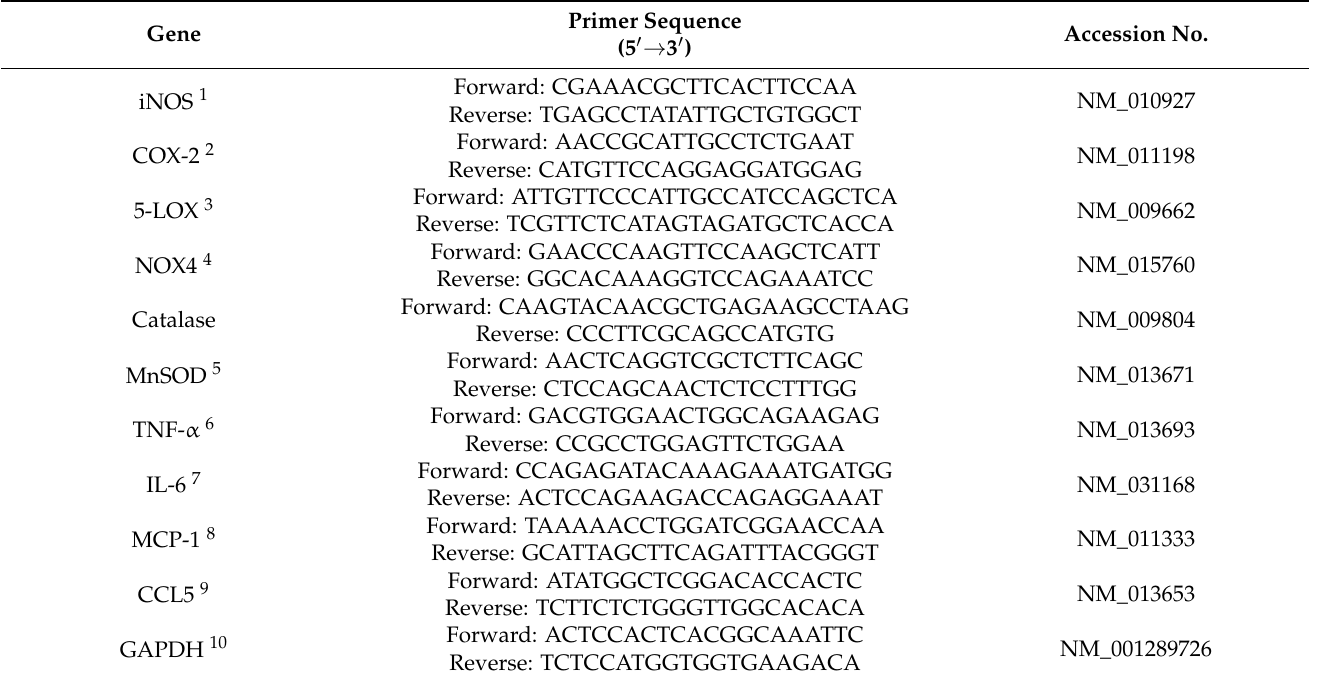
Table 1. List of primers used in this